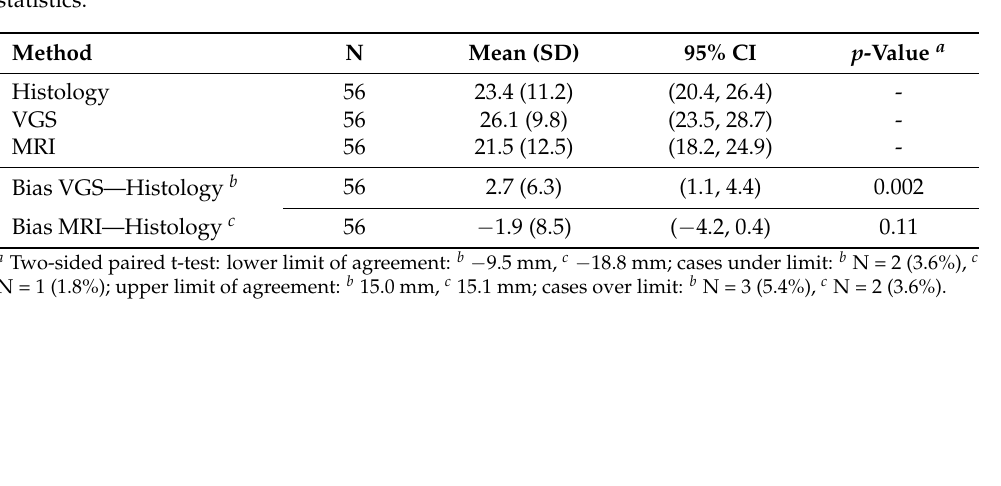
Table 2. Maximum diameter (mm) methods comparison with histology (gold standard) and summary